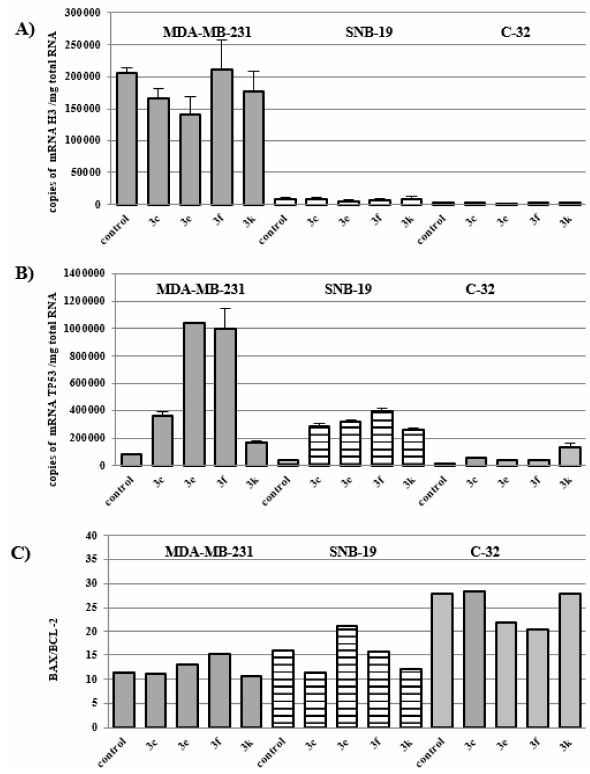
Figure 2. Effect of 3c , 3e , 3f , and 3k on transcriptional activity of: H3 ( A ); TP53 ( B ); BAX and BCL-2 ( C ) in MDA-MB-231, SNB-19, and C-32 cells.